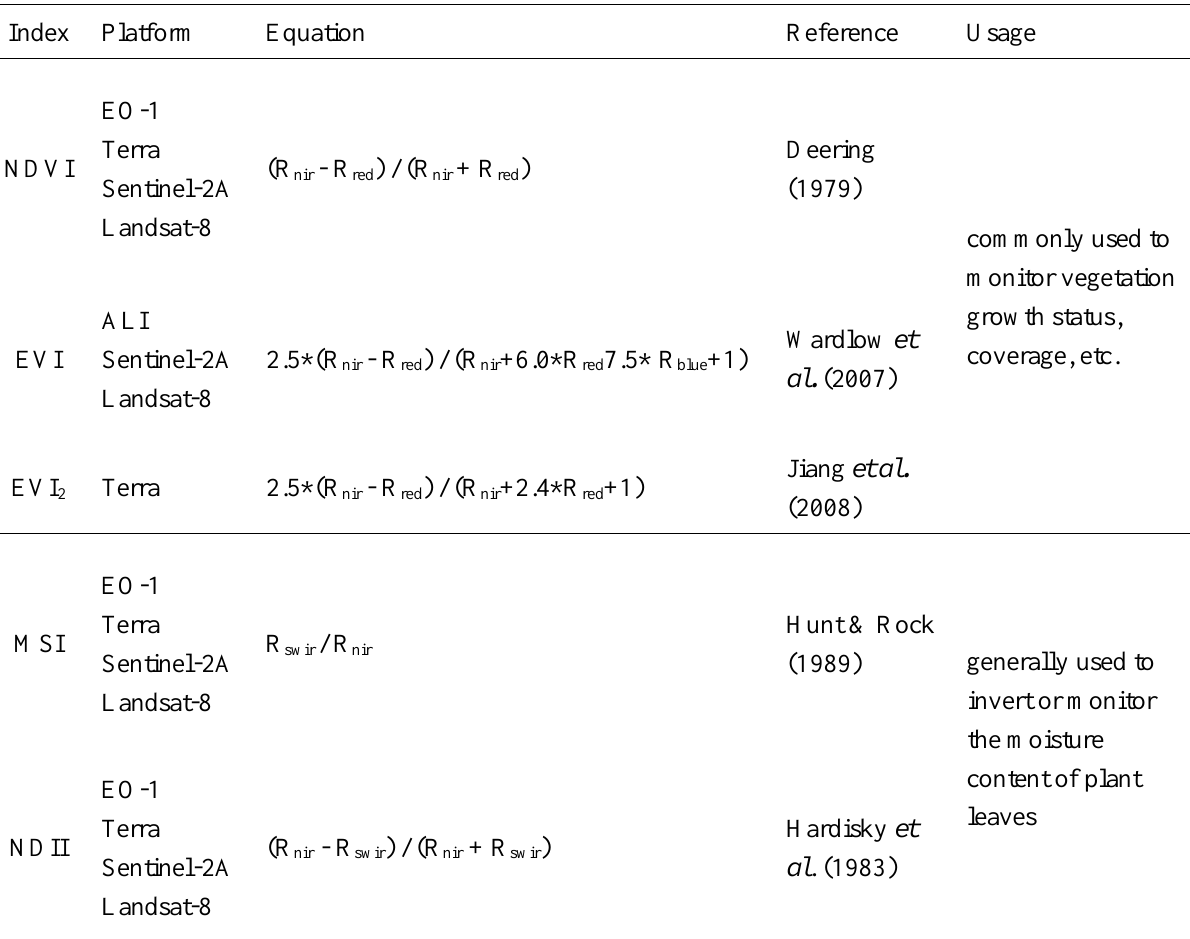
Table 1. Sensor-specific broad-band spectral indices employed in this